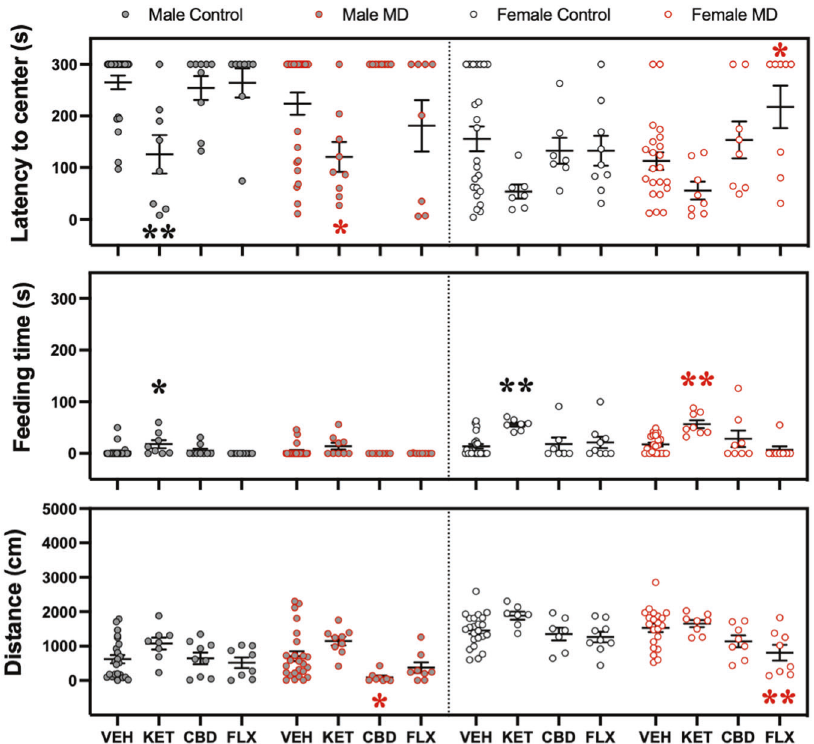
Fig. 5 Antidepressant-like effects as measured in the novelty-suppressed feeding test (NSF) during adulthood. Repeated effects (3 days post-treatment) exerted by adult ketamine, cannabidiol, or fl uoxetine exposure in male and female rats (Control or MD) in the NSF. Data represent mean ± SEM of the latency to center (s), feeding time (s), or distance traveled (cm). Individual values are shown for each rat (symbols). Three-way ANOVAs (independent variables: sex, early-life, and treatment) and two-way ANOVAs (independent variables: earlylife and treatment) are shown in Supplementary Tables 1 and 2 respectively. ** p < 0.01 and * p < 0.05 vs. the appropriate control group (Control or MD) and